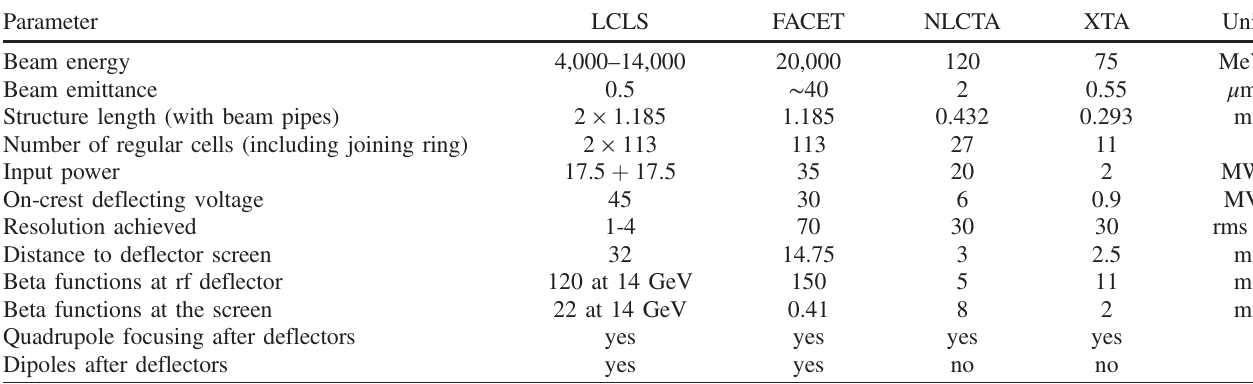
TABLE IV. Summary of practically achieved parameters from SLAC X -band deflector applications. Parameter